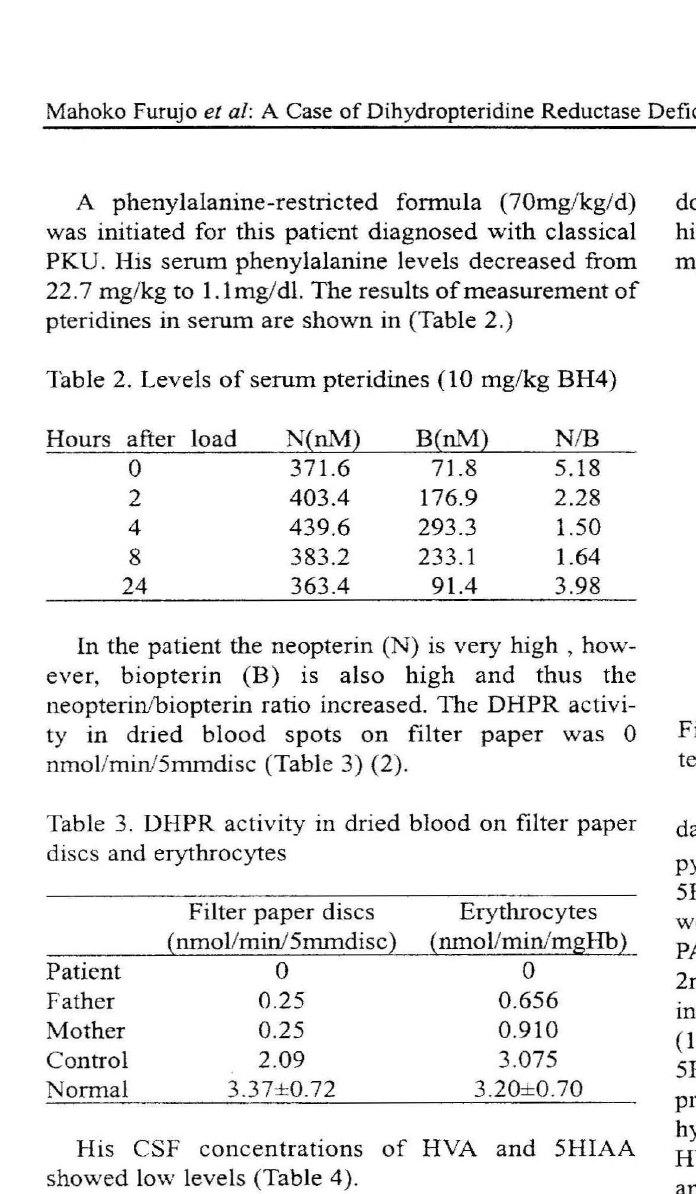
Table 4. CSF concentrations of HVA and SHIAA